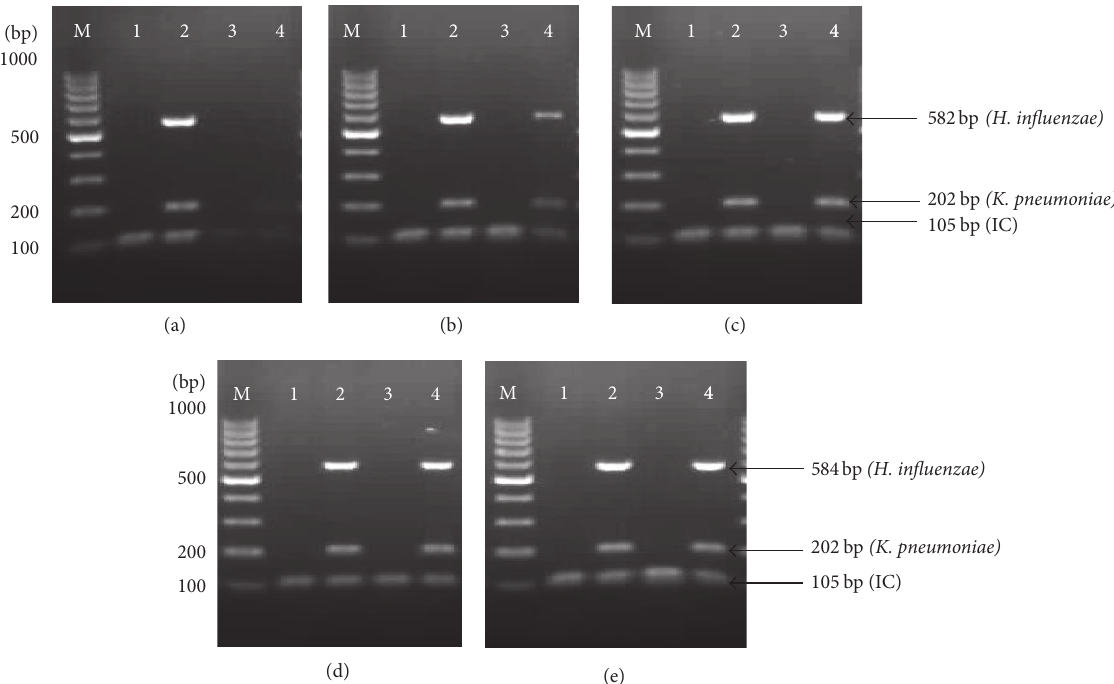
Figure 2: Effect of different concentrations of trehalose on the performance of thermostabilized multiplex PCR. (a) 2% stabilizer. (b) 4% stabilizer. (c) 6% stabilizer. (d) 8% stabilizer. (e) 10% stabilizer. Lane M: 100bp DNA ladder (Fermentas, USA); Lane 1: negative control before lyophilization (IC); Lane 2: positive control before lyophilization (IC + K. pneumoniae + H. influenzae ); Lane 3: negative control after lyophilization (IC); Lane 4: positive control after lyophilization (IC + K. pneumoniae + H. influenzae